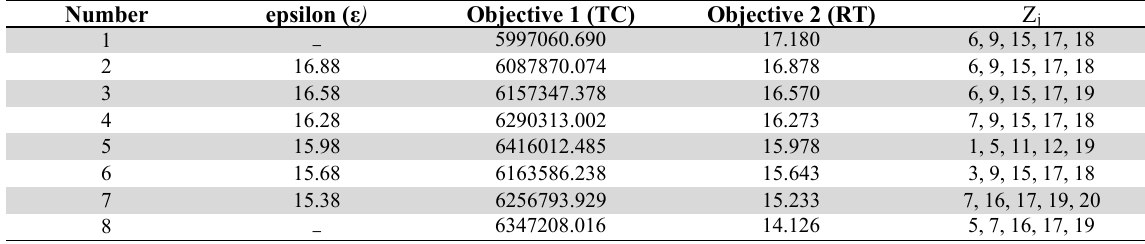
Results of solving the model for different values of